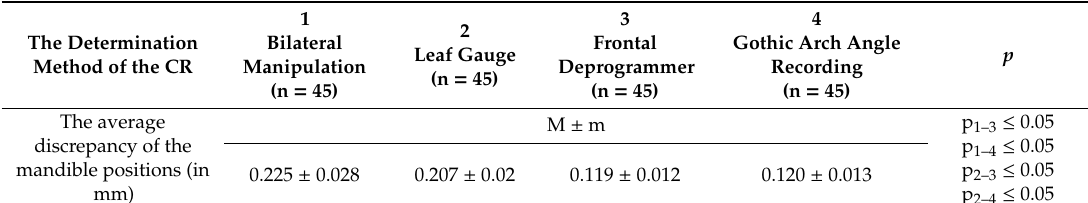
Table 1. Comparative assessment of the value of the di ff erence in the mandible position. CR = centric